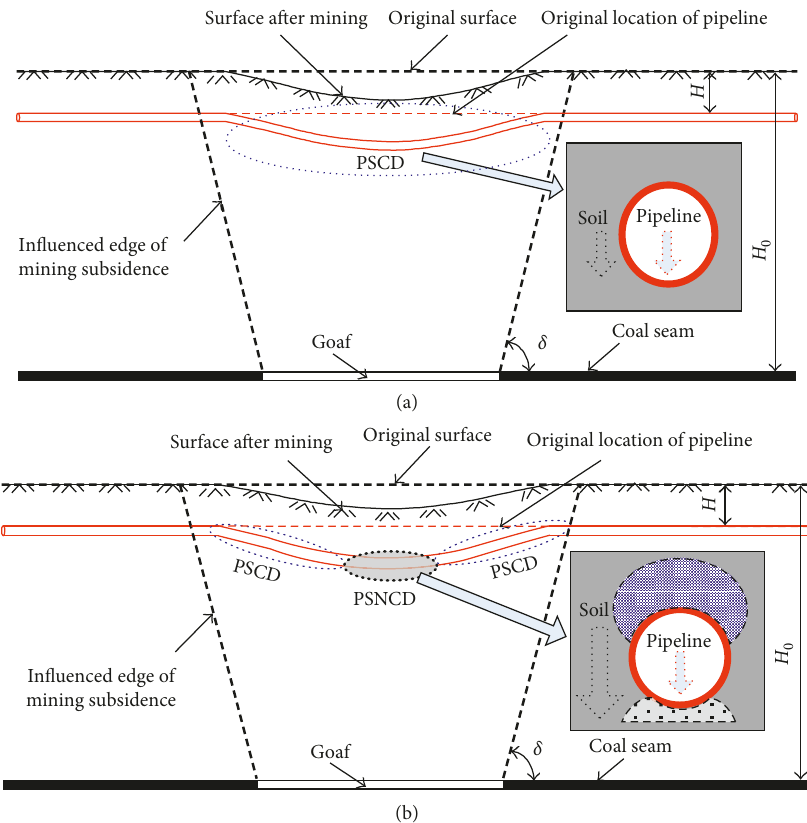
Figure 1: Deformation developments of a buried pipeline and its surrounding soil during mining subsidence: (a) PSCD stage during subsidence and (b) PSNCD stage during